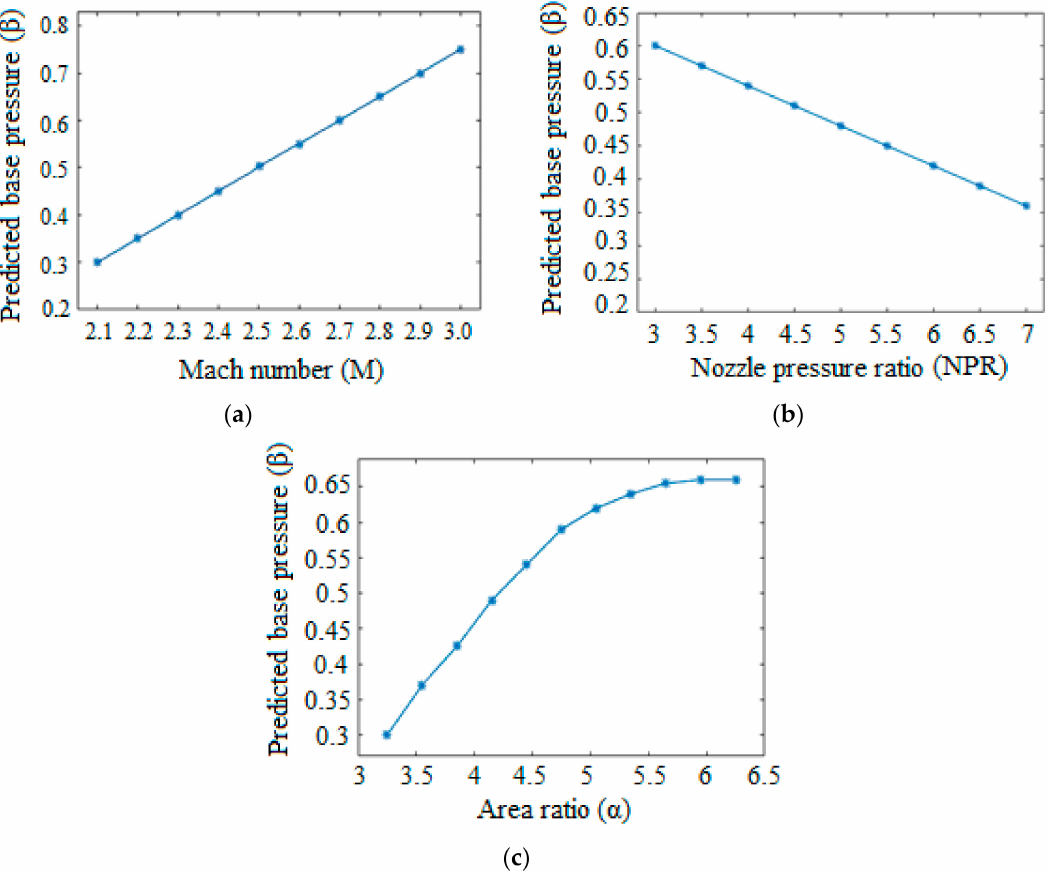
Figure 15. Variations in ( a ) metric value, ( b ) predicted base pressure ( β ), ( c ) relative error (%) versus training data of the SVM